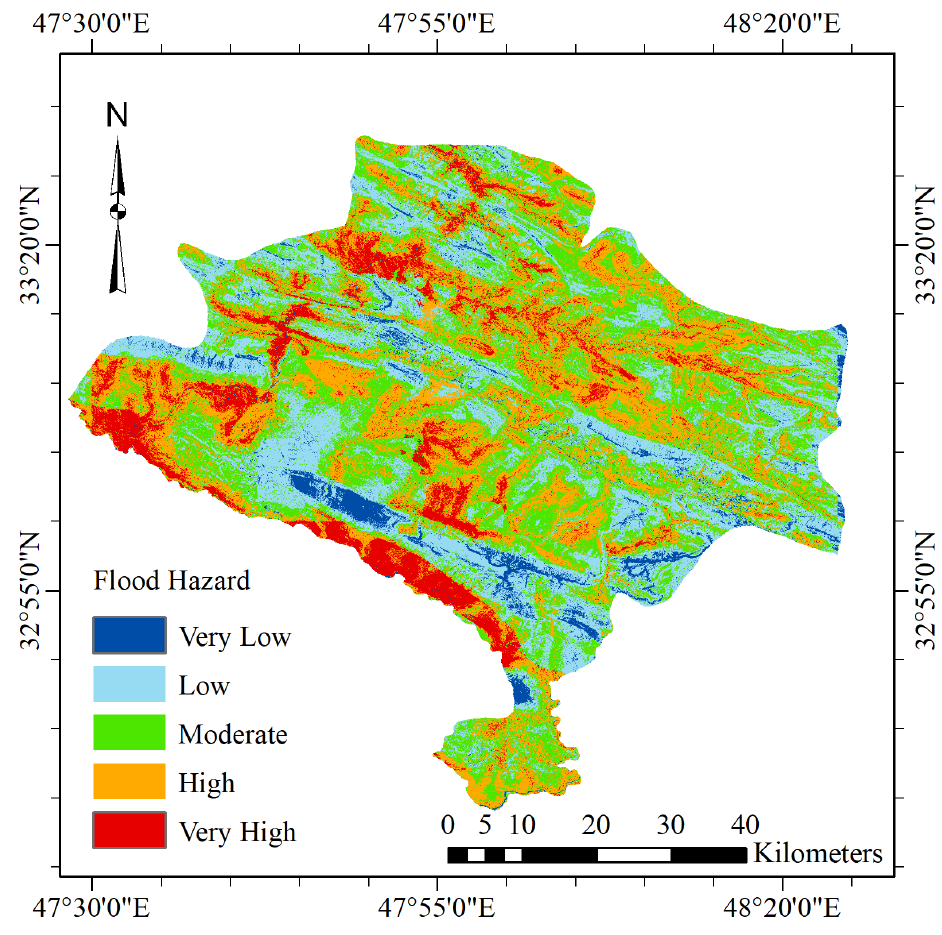
Figure 7. Flood Hazard Map of Pol-e Dokhtar.